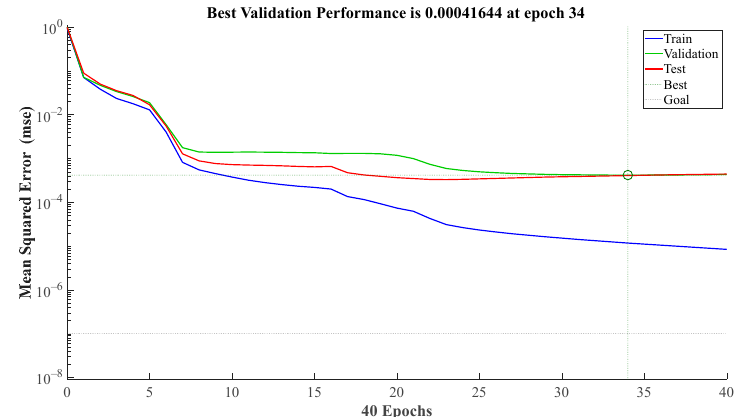
Figure 22. Graph of the number of network iterations and MSE.